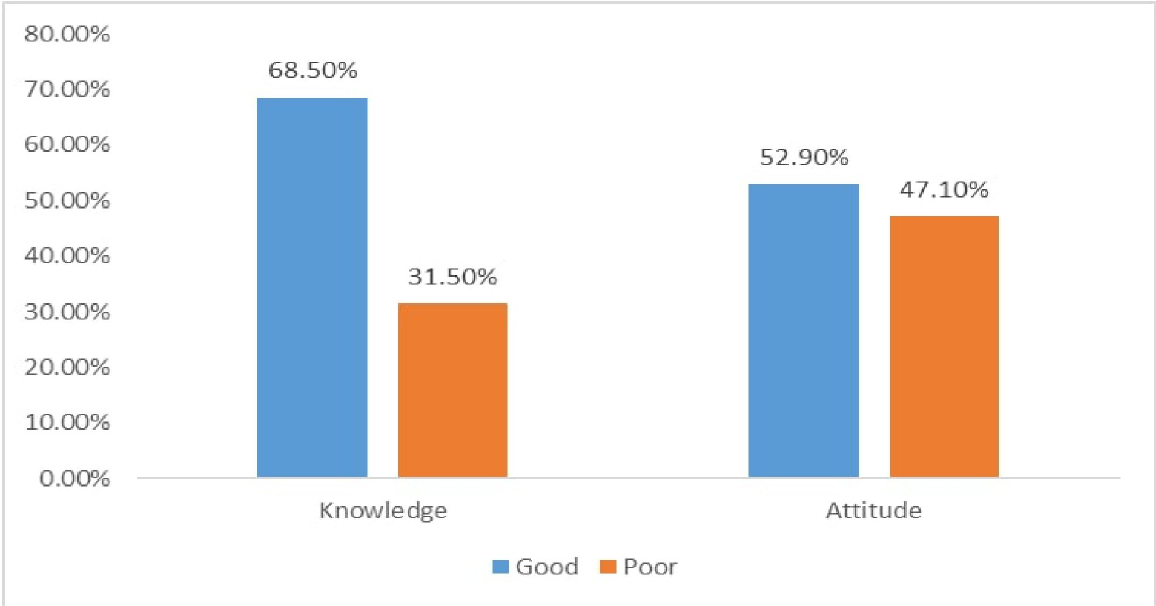
Fig 2. Knowledge and attitude towards telemedicine among health professionals working at private hospitals in Amhara region, Ethiopia, 2021.